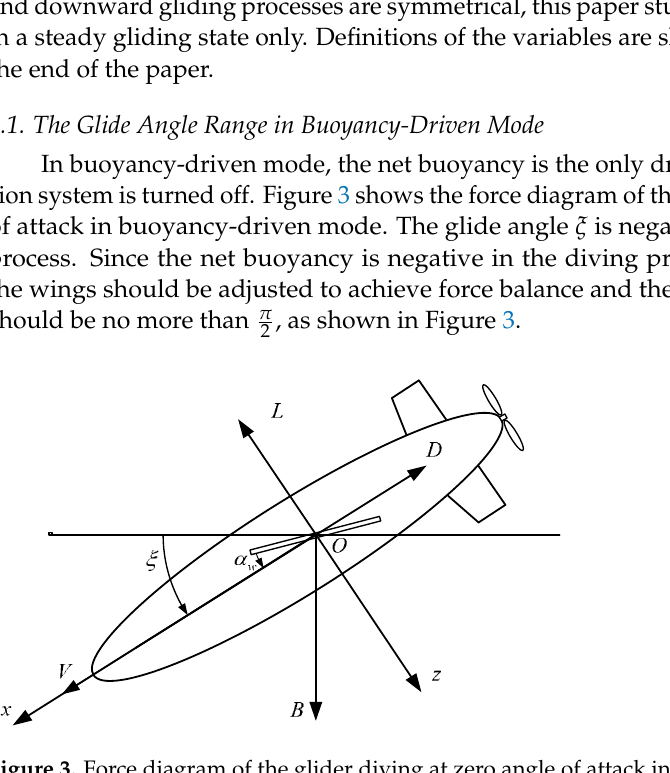
Figure 3. Force diagram of the glider diving at zero angle of attack in buoyancy-driven mode.